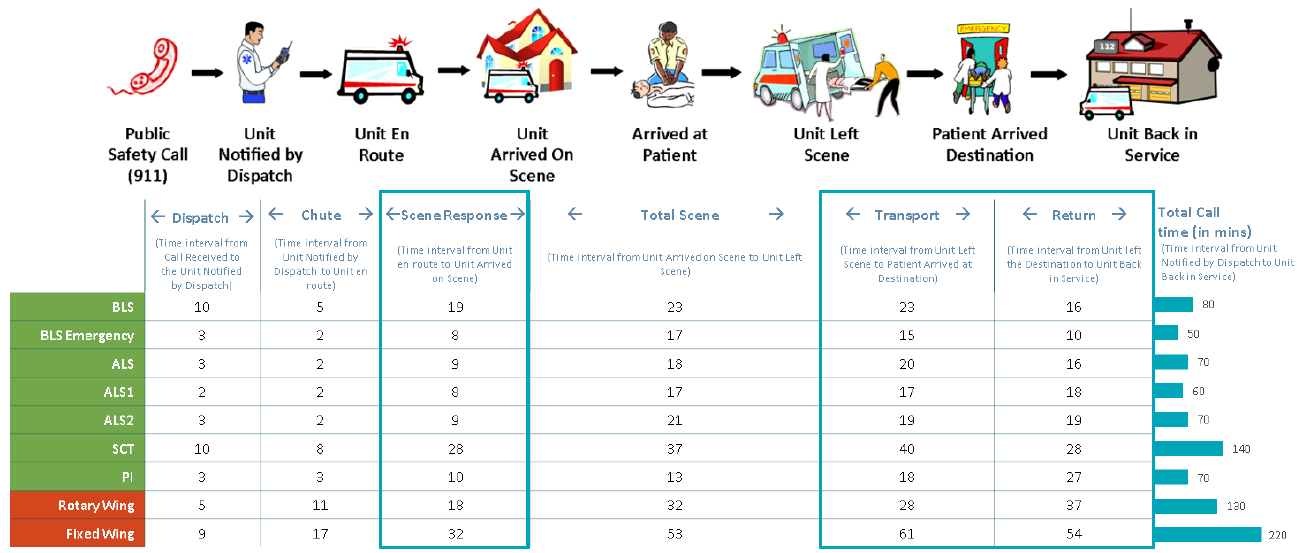
Figure 1. Air ambulance concept of operations and temporal phases (times shown in minutes). Source: Data from [27].